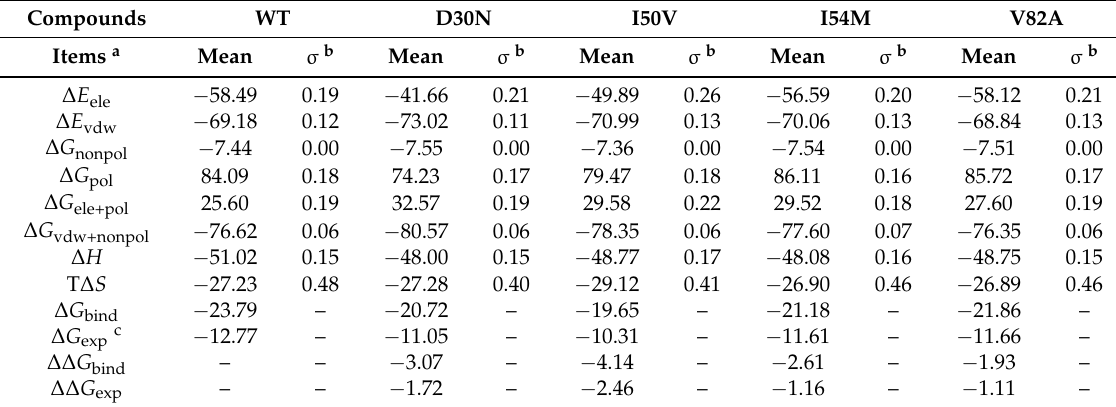
´ 51.02 ´ 48.00 T ∆ S ´ 27.23 0.48 ´ 27.28 ´ 23.79 – ´ 20.72 – ´ 19.65 – ´ 21.18 – ´ 21.86 – ∆ G c ´ 12.77 – ´ 11.05 – ´ 10.31 – ´ 11.61 – ´ 11.66 – exp ∆∆ G bind – – ´ 3.07 – ´ 4.14 – ´ 2.61 – ´ 1.93 – ∆∆ G exp – – ´ 1.72 – ´ 2.46 – ´ 1.16 – ´ 1.11 – a The symbols of the energy terms are described in the section on MM-PBSA calculations. All values of energies are given in kcal/mol; b Standard errors were calculated by σ = standard deviation/N 1/2 [29,34,35]; c The experimental binding free energies ( ∆ G exp ) were calculated from published inhibition constants ( K i )